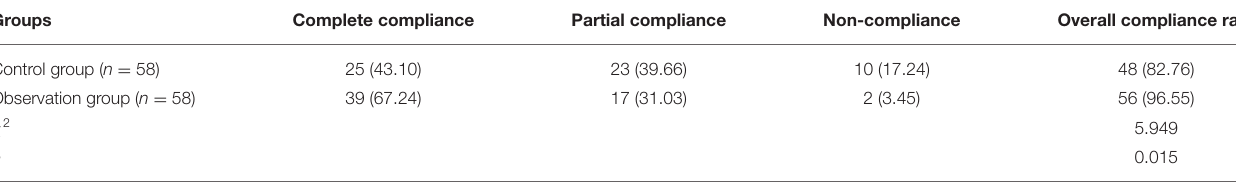
TABLE 3 | Comparison of medication compliance between the two groups of patients [ n